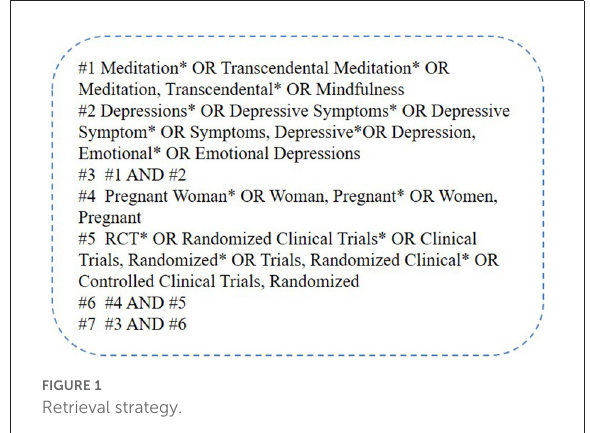
FIGURE1 Retrieval